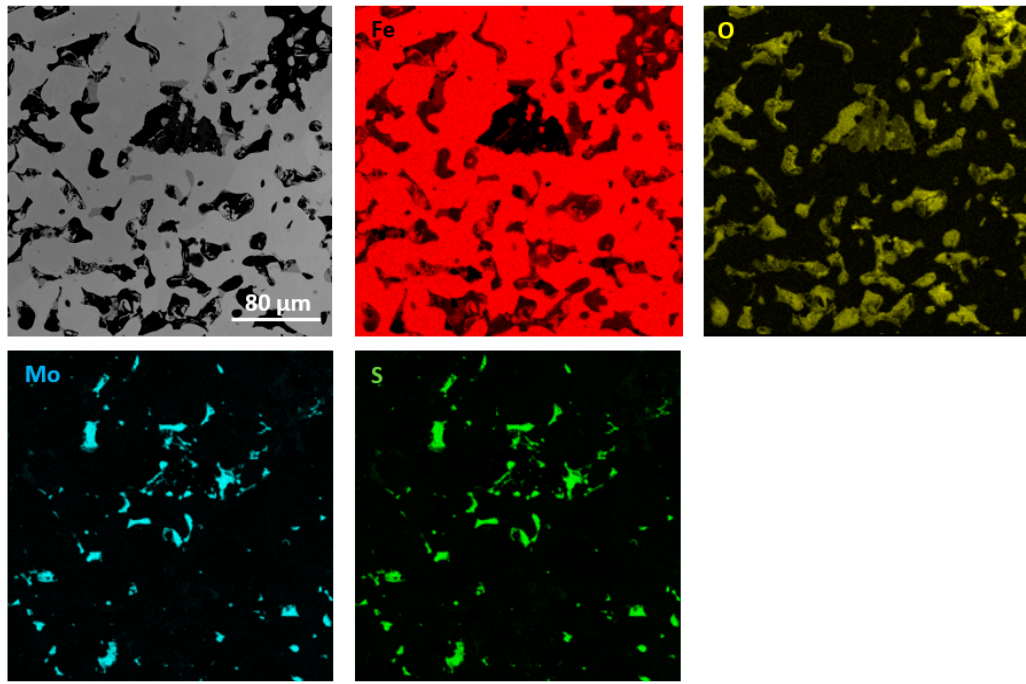
Figure 11. EDS mapping of sintered Fe with the addition of MoS 2 with a size of 1.5 μ m (for pressing pressure 350 MPa).